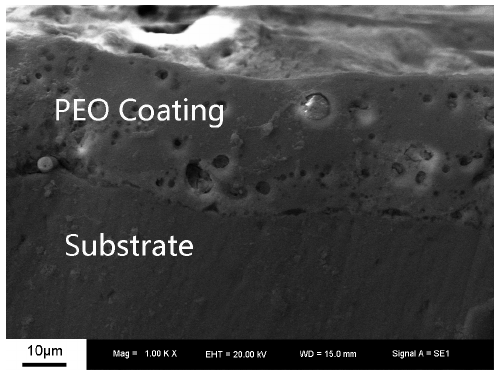
Figure 3. SEM images of the cross section of the PEO coating.